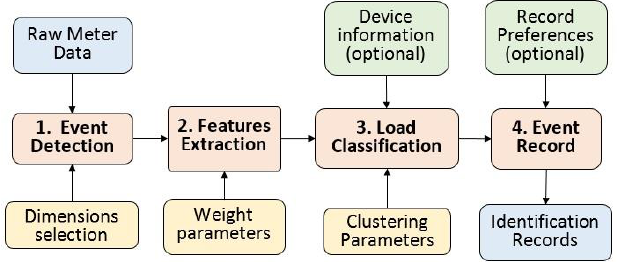
Figure 5. DNB Block Scheme. The process comprises four main steps.